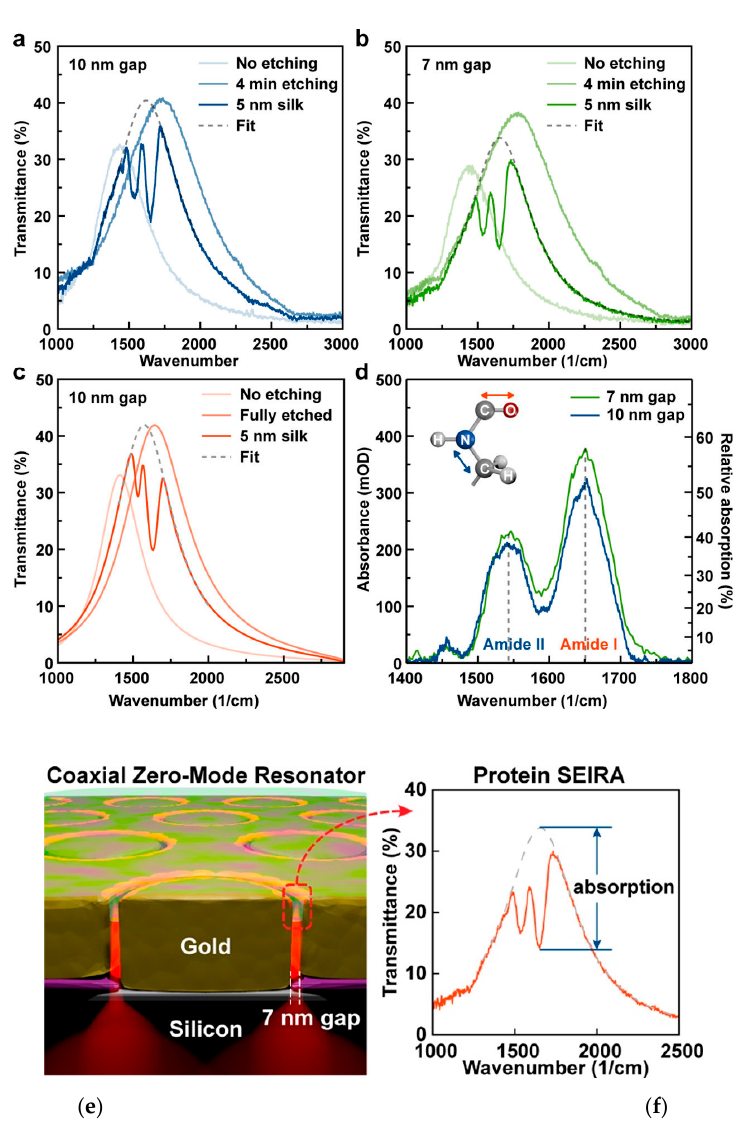
Figure 8. Transmission spectra for no etching, after etching and silk coated conditions for ( a ) 10 nm and ( b ) 7 nm wide nanogap respectively. ( c ) Simulated transmission spectra using 10 nm wide nanogaps under three conditions are plotted for comparison. ( d ) Absorption of 5 nm silk by using 10 nm and 7 nm wide nanogap. ( e ) Schematic presentation of nanogap-based coaxial zero-mode resonator. ( f ) Fitting curve is used in transmission spectra to demonstrate the absorption intensity. Adapted from [99], with permission © 2018 American Chemical Society.